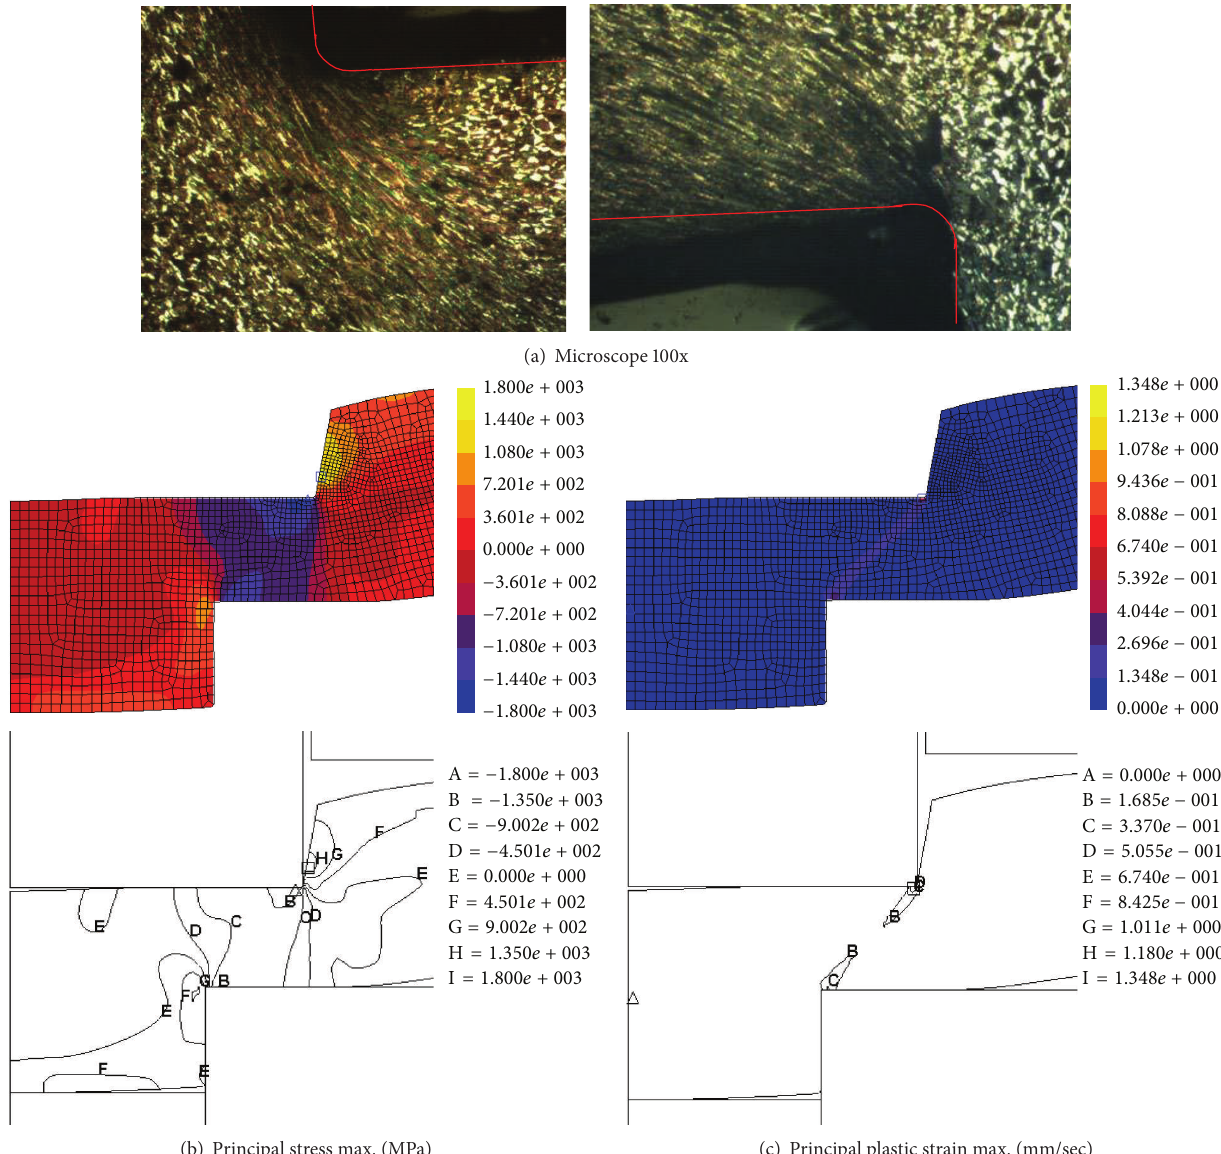
Figure 10: Microstructure behavior analysis for 60% punch